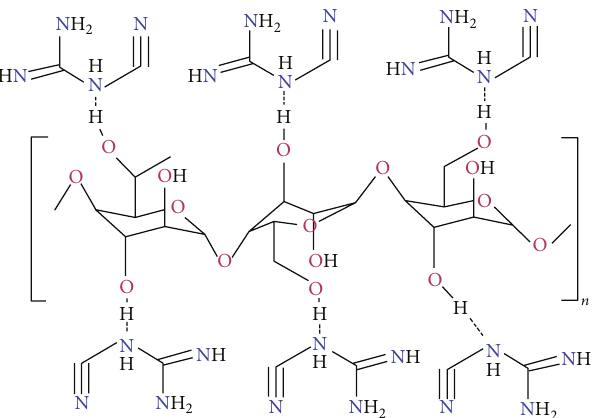
Figure 2: Dicyandiamide molecules linked to cellulose molecule.